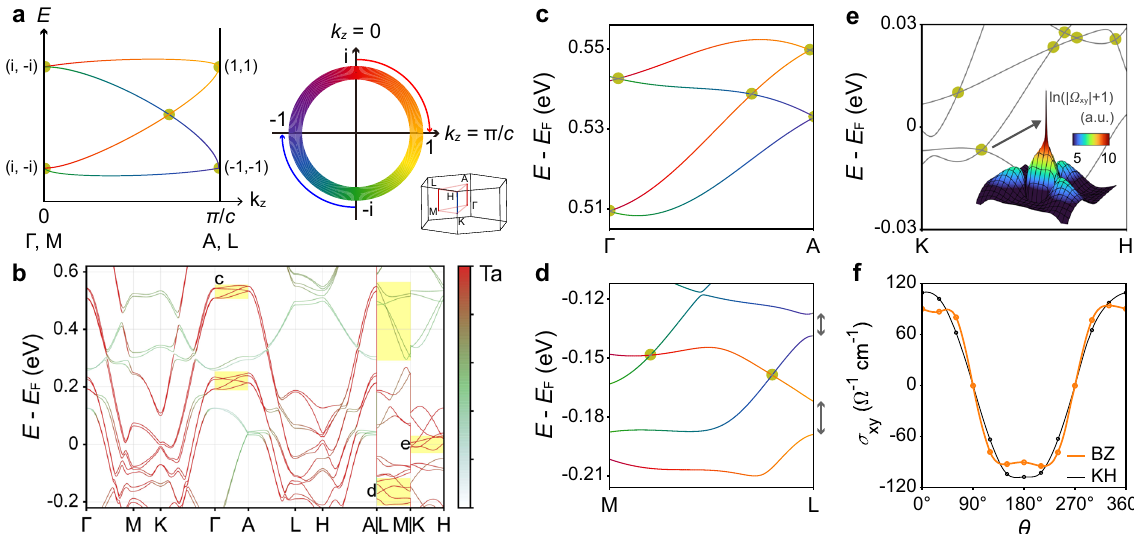
Fig. 4 Hourglass Weyl dispersion with noncollinear magnetic order. a A schematic band connectivity diagram for a screw-invariant line. The color scale indicates the 2 1 screw rotation eigenvalues of the Bloch bands. Kramers pairs with eigenvalues ( i , − i ) are paired at k z ¼ 0 ( Γ , M), and those with (1, 1) or ( − 1, − 1) are paired at k z ¼ π = c (A, L). The olive circles represent the Weyl point. The lower right fi gure shows the Brillouin zone of Co 1/3 TaS 2 with high symmetry points being marked. b The calculated band structure of the Γ þ spin con fi guration of Co 1/3 TaS 2 . The Ta- 2 5 d portions are depicted by color code. Fermi level is set to zero energy. The yellow-colored regions correspond to the hourglass Weyl dispersion, some of which are enlarged in c – e . c – e The calculated band structure along the Γ A , ML and KH lines, respectively (some of the yellow regions in b ). Due to the broken TRS, the band degeneracy at the TRIM points is lifted. The color plot in e displays the calculated Berry curvature | Ω xy | near the Weyl point designated by an arrow in a logarithmic scale. f The calculated AHC by integrating over the whole Brillouin zone (BZ) (orange color) and only around the KH line (black), respectively. θ denotes the angle of uniform spin rotation around the c -axis; see Fig.